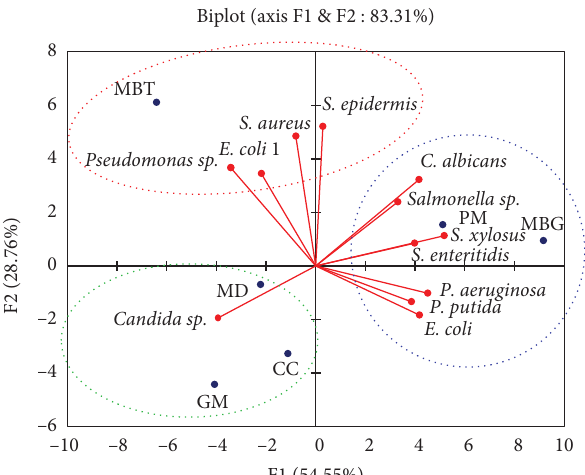
Figure 1: Distribution of microbial species isolated from fresh beef and sampling sites on F1 × F2 axis. PM � “Petit March´e”; GM � “Grand March ´ e”; MD � “Dang market”; CC � “Centre Commercial”; MBG � “Bamnyanga market”; MBT � “Bantail